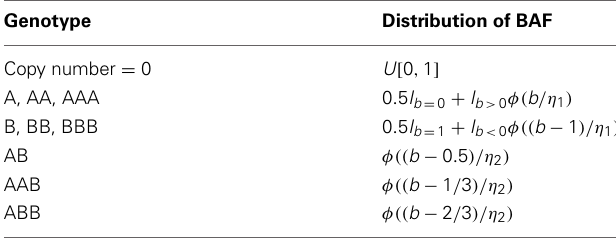
Table 1 | Distribution of the B Allele Frequencies (BAF) given the genotype and the copy